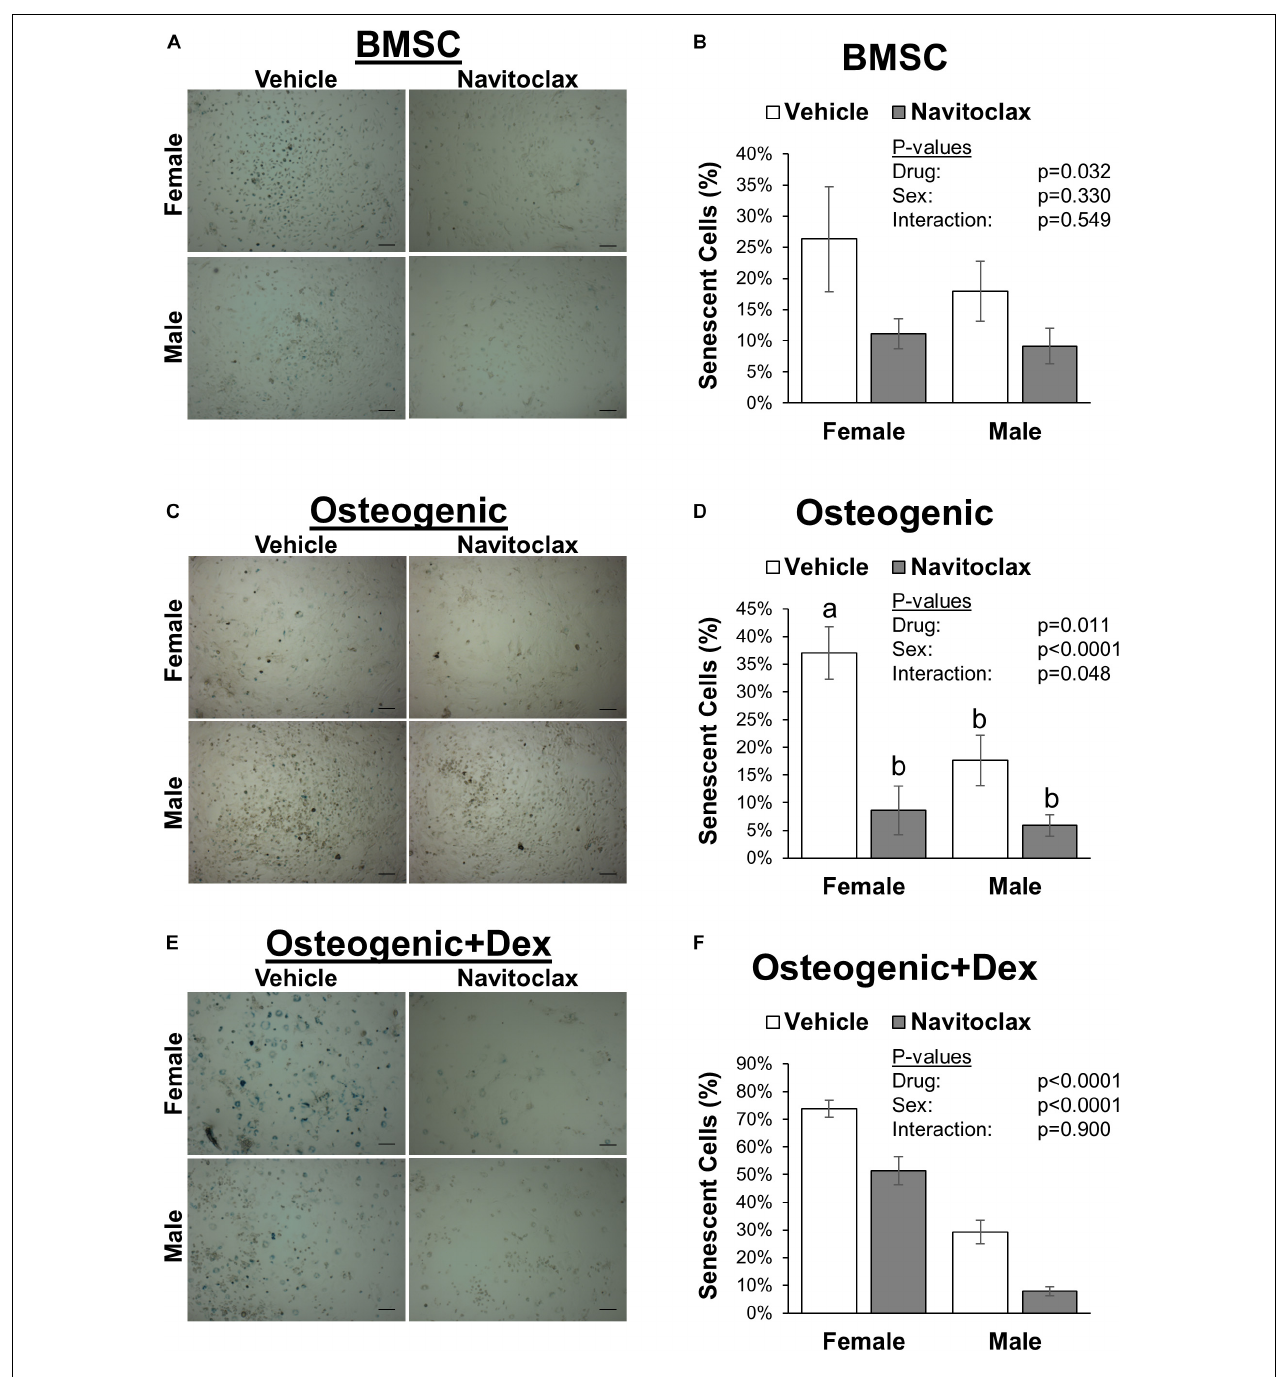
FIGURE 2 | Navitoclax decreased senescent cell burden in BMSC and osteogenic cultures. Primary BMSC were harvested from 24 month old male and female mice and treated with navitoclax (5 µ M) or vehicle (DMSO) for 5 days in BMSC growth medium (A,B) , osteogenic medium (C,D) , or osteogenic medium with 100 nM dexamethasone (E,F) . Senescent cells were identified by blue staining and quantified relative to total cell number. Representative images for each condition are shown in (A,C,E) . Scale bar: 100 µ m. P -values shown represent statistical comparisons between groups, p -value for “drug” in 2-factor ANOVAs represents the comparison between navitoclax (gray) and vehicle (white)-treated